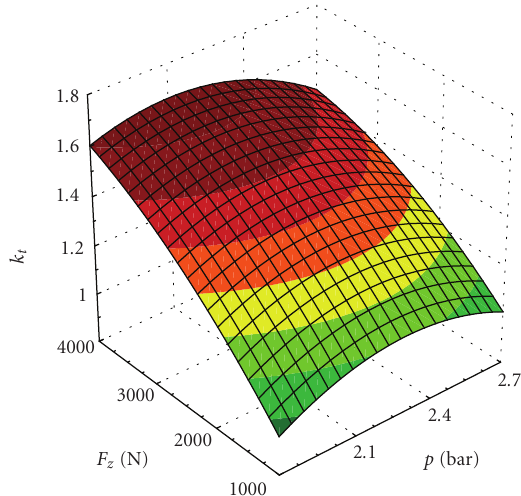
Figure 10: Coe ffi cient of tread loading equilibrium for Tire 2 as a function of pressure and vertical load.